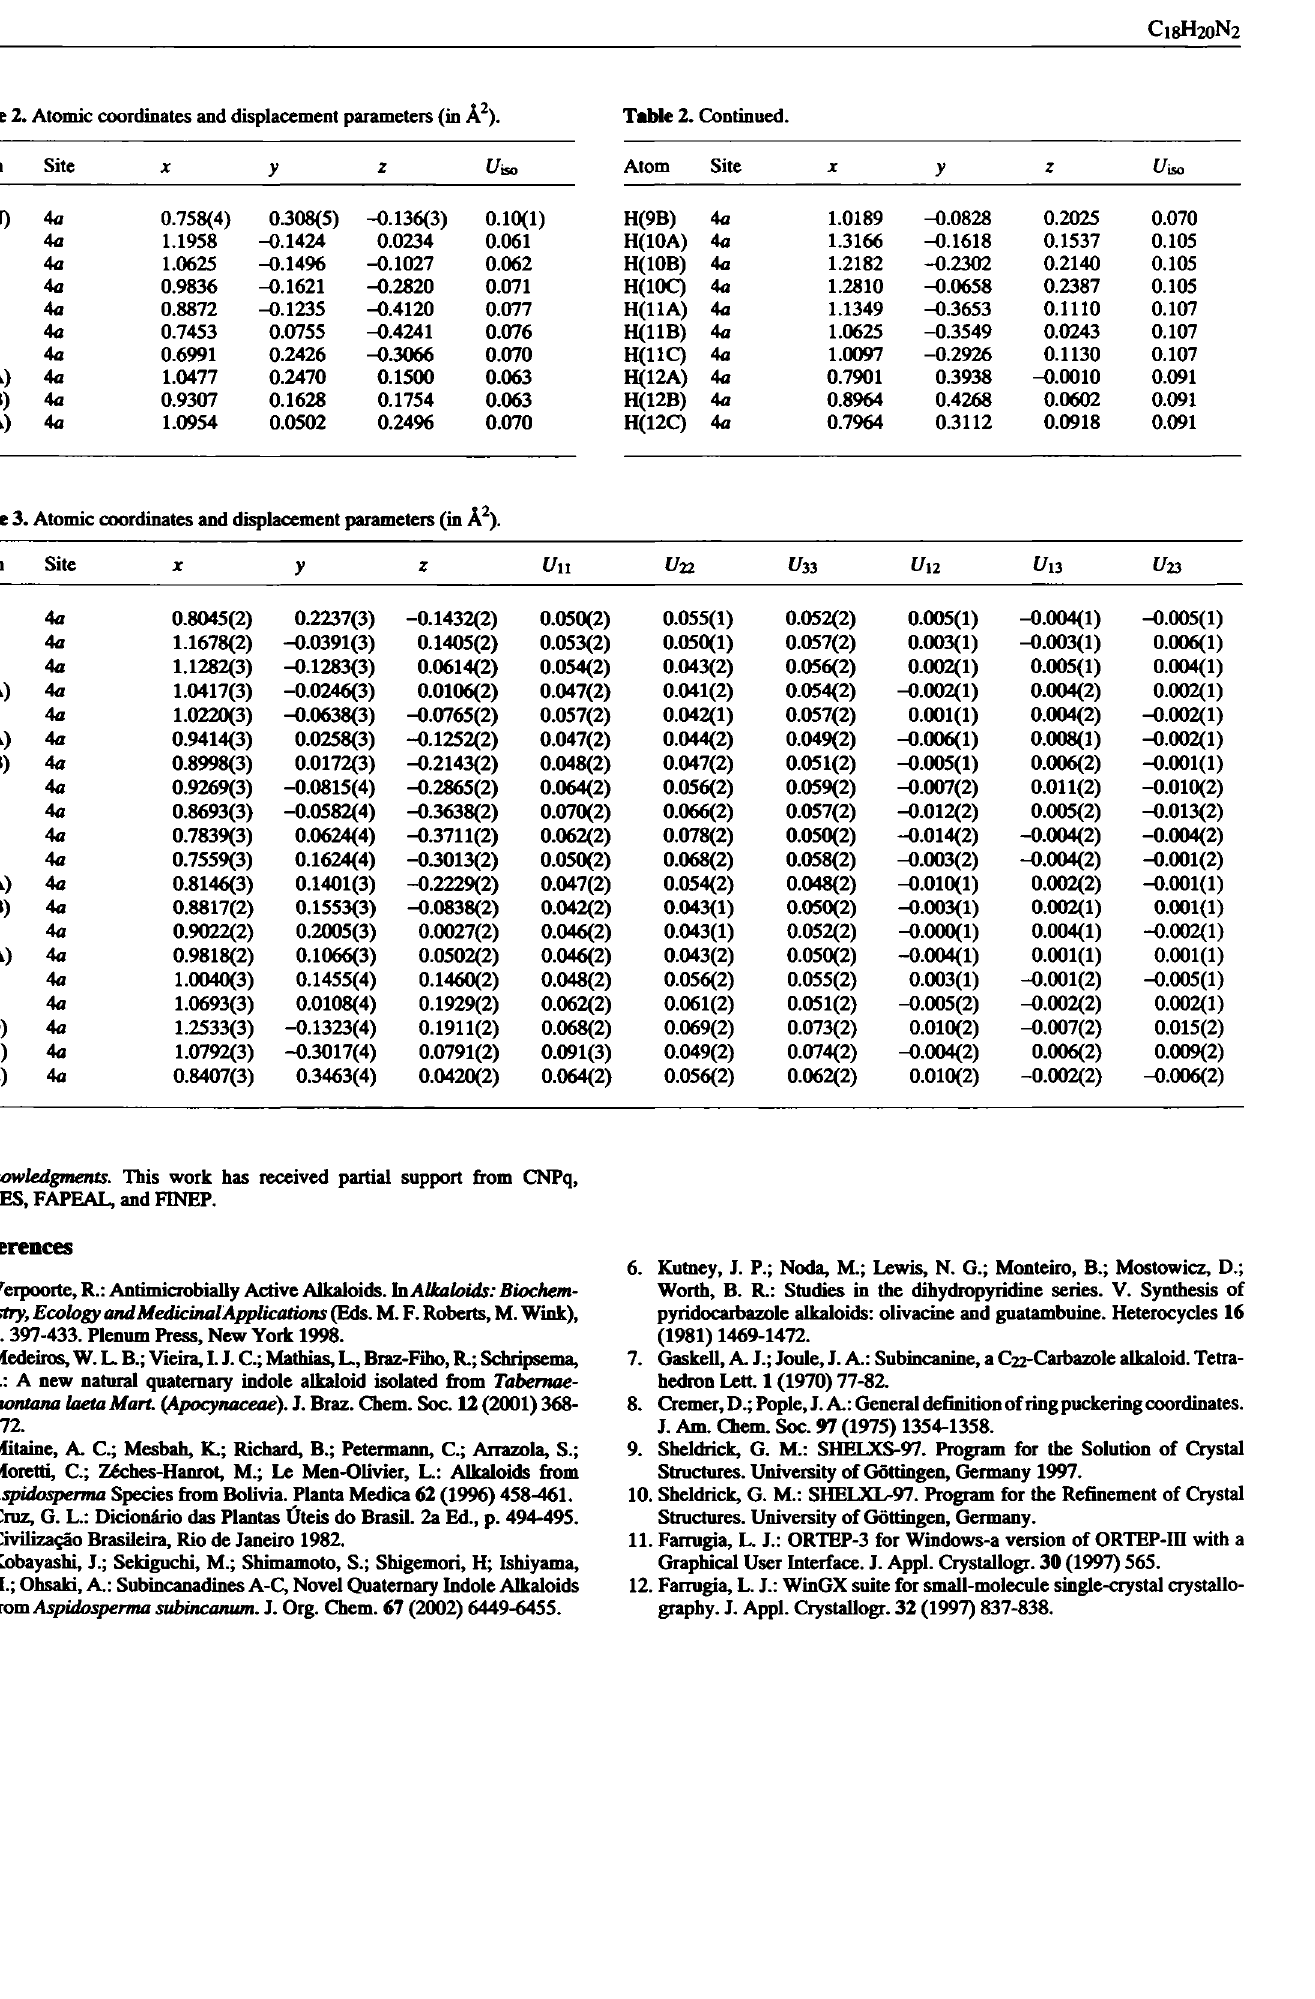
Table 2. Atomic coordinates and displacement parameters (in A 2 ).